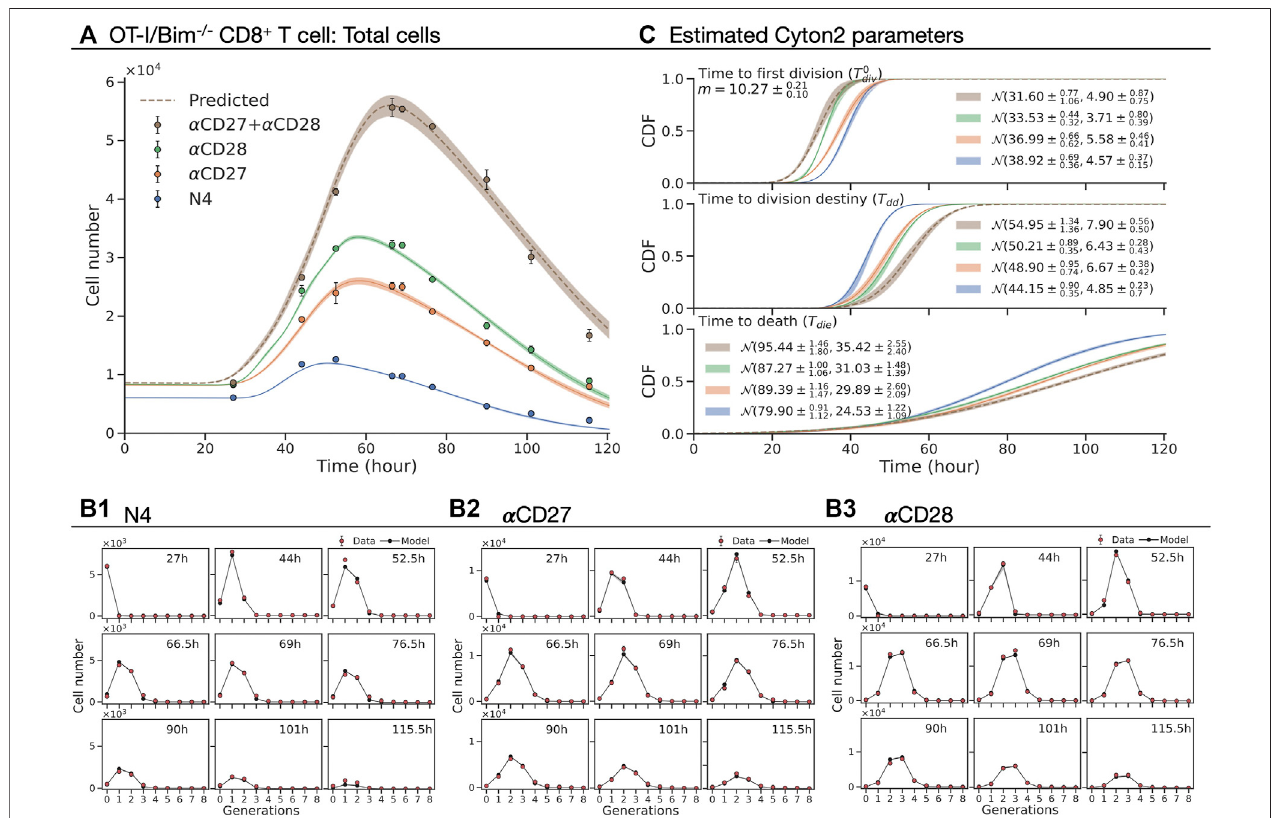
FIGURE 6 | Fitting the Cyton2 model to OT-I/Bim − / − CD8 + T cell FACS data (Marchingo et al., 2014). The cells were stimulated with N4 as basis for all other conditions. (A) Harvested total cell numbers (dot: mean ± SEM) overlaid with the model extrapolation and 95% con fi dence band from bootstrapping. (B1 – B3) Live cells per generation and the model extrapolation at harvested time points. (C) 19 jointly fi tted parameters ( T 0 div , T dd , T die for each of N4, α CD27 and α CD28; a shared subsequent division time, m ) and their 95% con fi dence intervals. The fi tted and predicted values of mean and standard deviation are labelled in the legend for normally distributed random